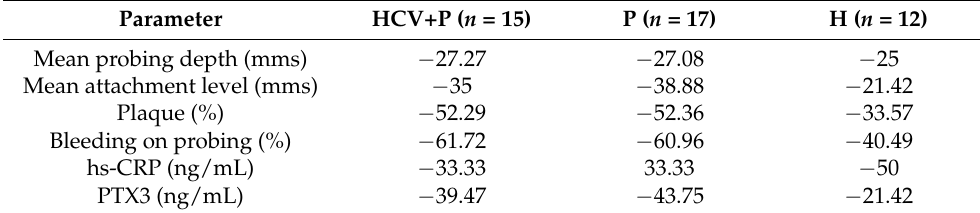
Table 4. Evolution (%) of analyzed parameters from baseline to